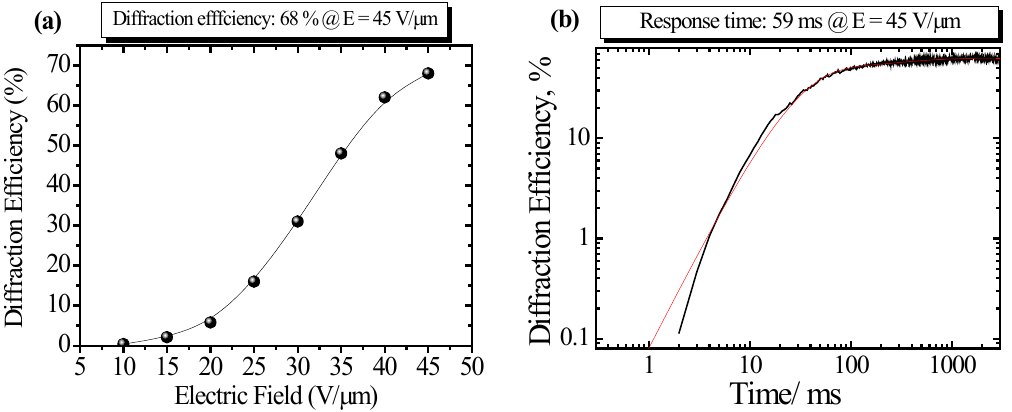
Figure 3. ( a ) Plots of diffraction efficiency as a function of electric field. The sample: polymer composite of PVCz/7-DCST/CzEPA/TNF (44/35/20/1 by wt); ( b ) Time response profile of optical diffraction. Red curve is the plots fitted by bi-exponential function of Equation